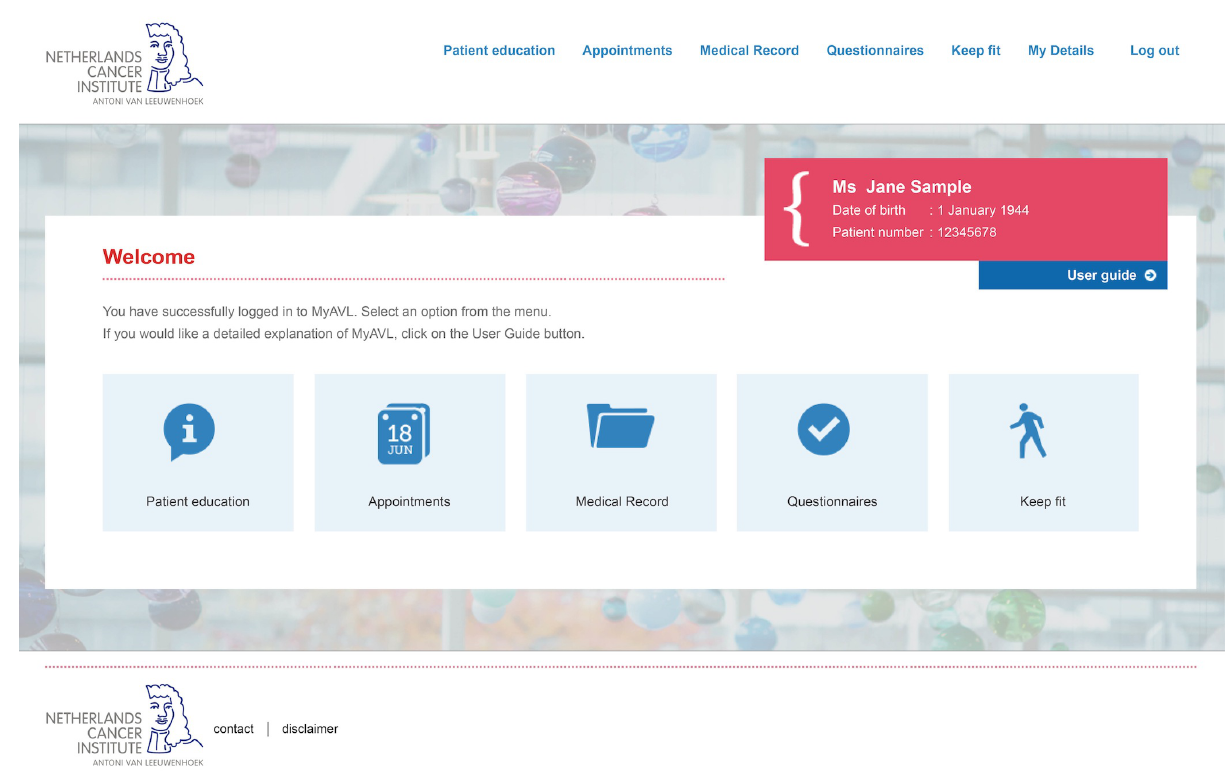
Figure 1. MijnAVL: